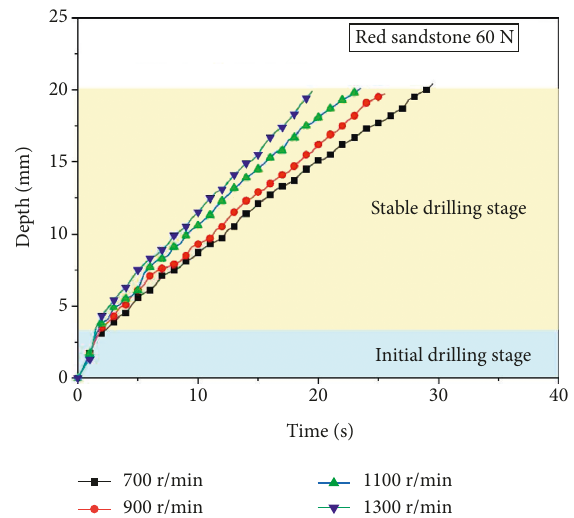
Figure 12: The variation of the drilling depth with time for the red sandstone under different RS (DP � 60